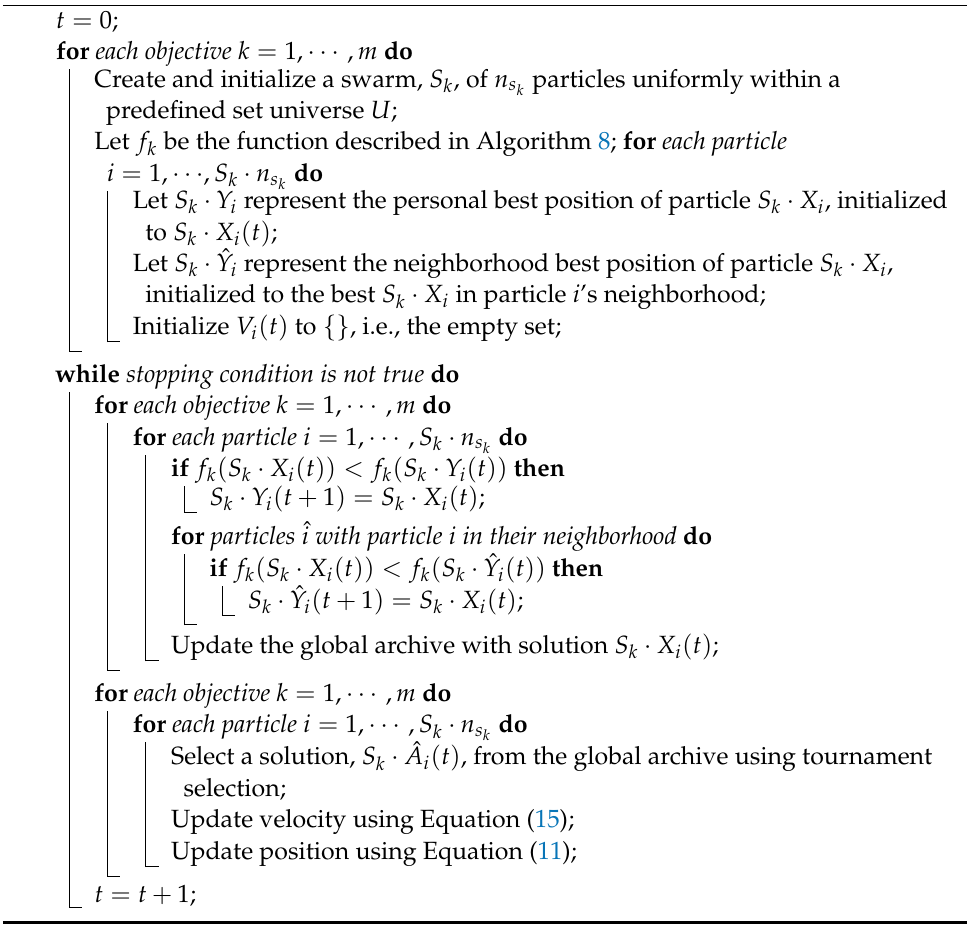
Algorithm 9: Multi-Guide Set-Based Particle Swarm